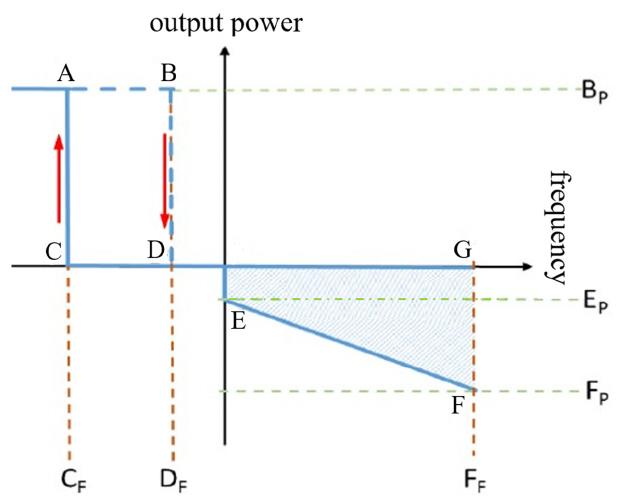
Figure 4. The response curve of the sReg mode.